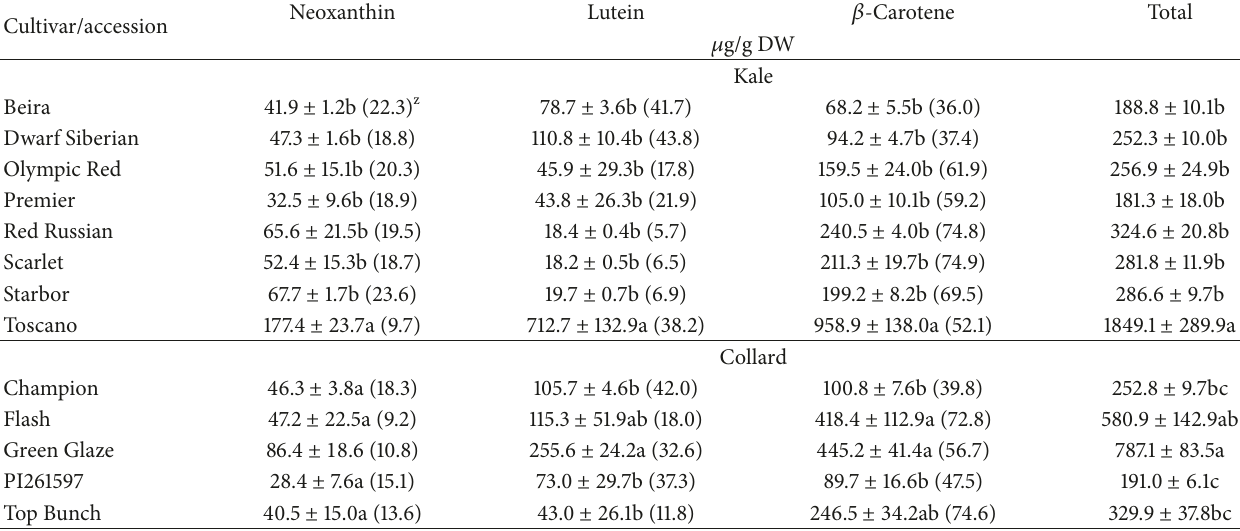
Table 1: Carotenoid composition of freeze-dried kale and collard